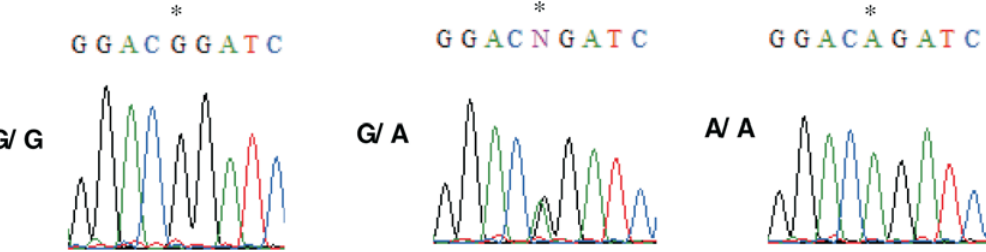
Figure S3 - A promoter polymorphism of p14 ARF at position -1477 in normal Japanese individuals. Genomic DNA was amplified by PCR with a forward primer at positions -1649 to -1627 and a reverse primer at -1090 to -1112 of the p14 ARF gene; the nucleotide sequences were determined by directly se- quencing the PCR products. These sequencing reactions were performed using a primer at position -1649 to -1627. (*) shows nucleotides at position -1477 in the p14 ARF promoters, where “N” indicates heterozygous nucleotides containing G and A. Nucleotides around the polymorphic position (*) are indicated.The-1477polymorphicfrequencyin9healthyJapaneseindividualswas33.3%forhomozygousG/G,44.4%forheterozygousG/A,and22.2% for homozygous A/A. Nucleotide positions are numbered with respect to nucleotide G (Robertson and Jones, 1998) at the initiation site of transcription in the p14 ARF gene (accession number: